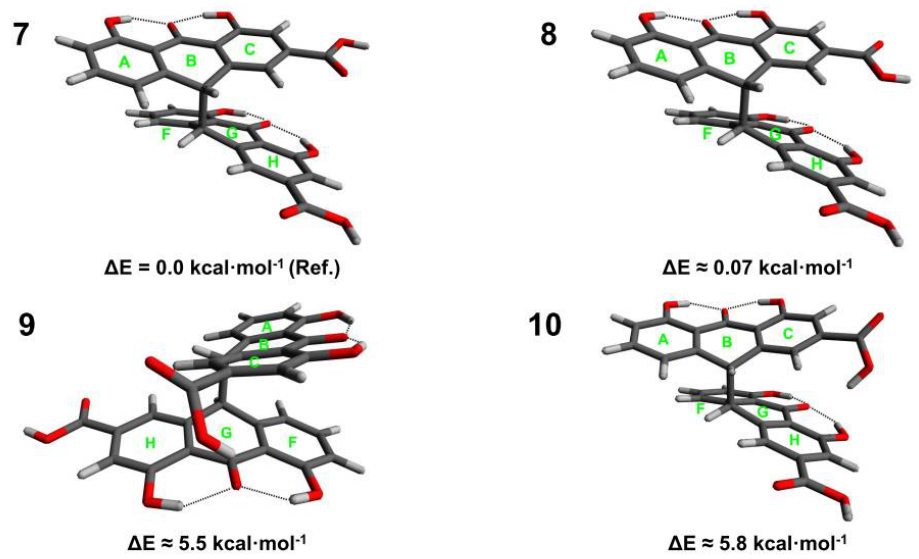
Figure 2. Conformers ( 7 – 10 ) of sennidin B.